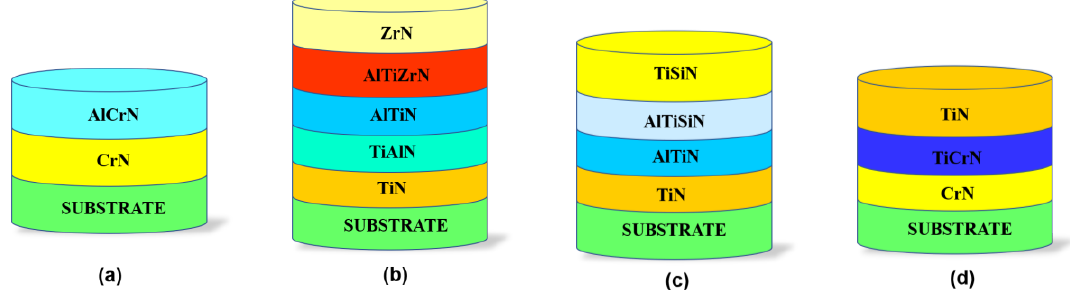
Figure 1. Schematic view of the coating layers architecture deposited on non-nitrided and nitride AISI H13 steel: ( a ) coating A; ( b ) coating B; ( c ) coating C and ( d ) coating D.